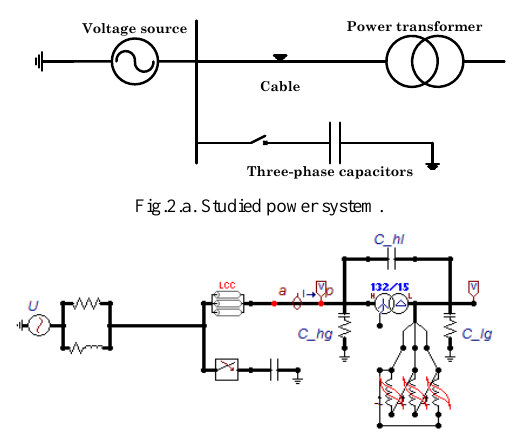
Fig.2.b. ATP Draw circuit for simulation.